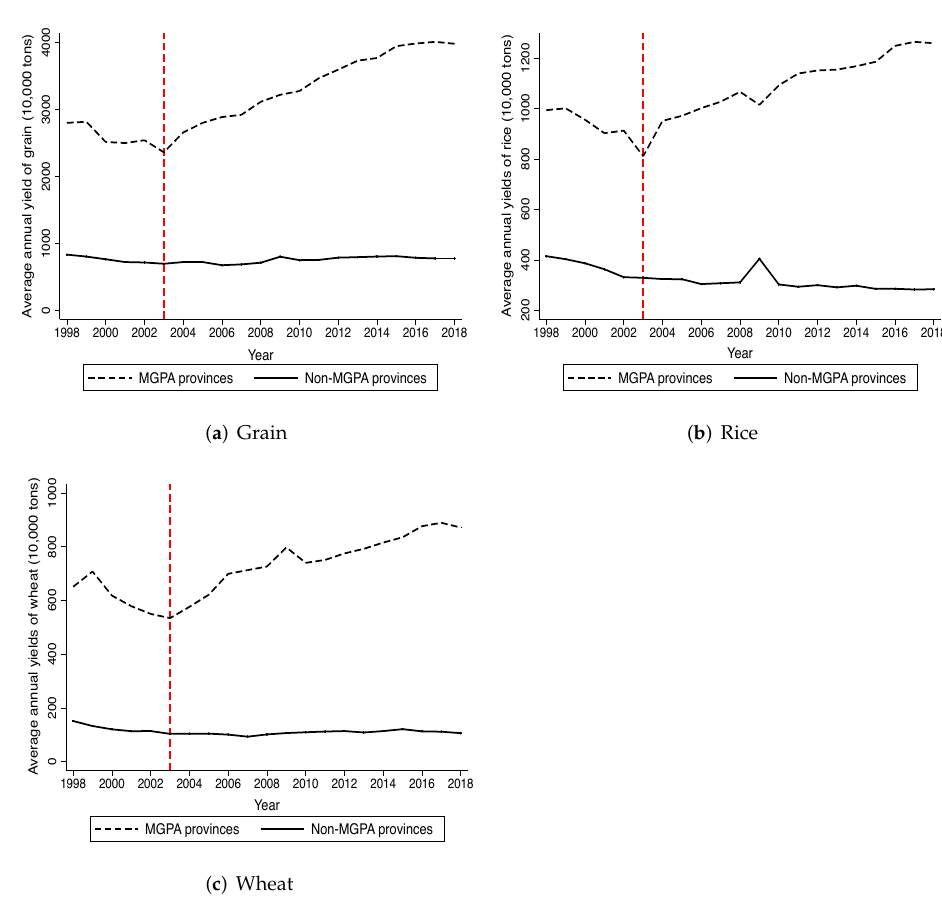
Figure 2. Yields of grain, rice and